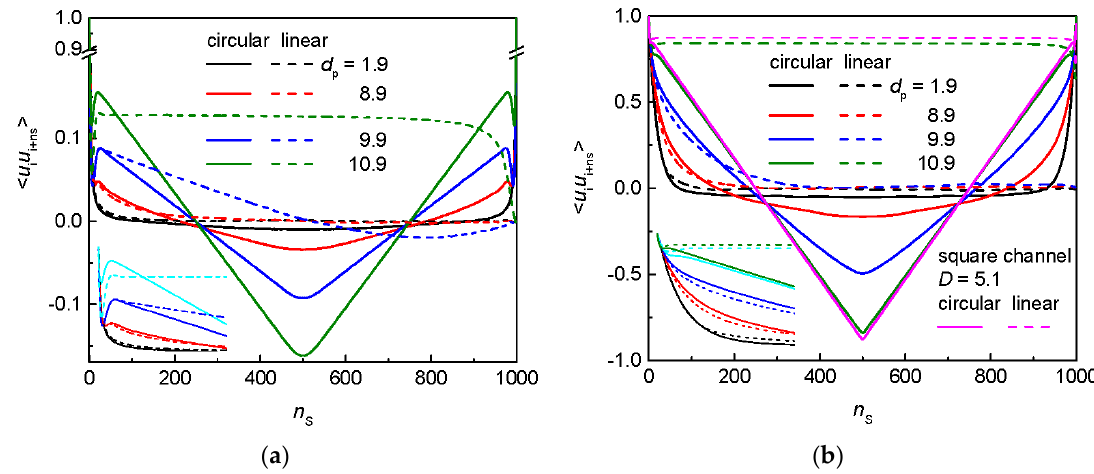
Figure 9. Orientation correlations for: a flexible chain ( a ); and a semiflexible chain ( b ) of circular and linear topology in an array of nanoposts of fixed post separation S p = 12 and various post diameters d p . The insets zoom in the initial decay of the orientation correlations.